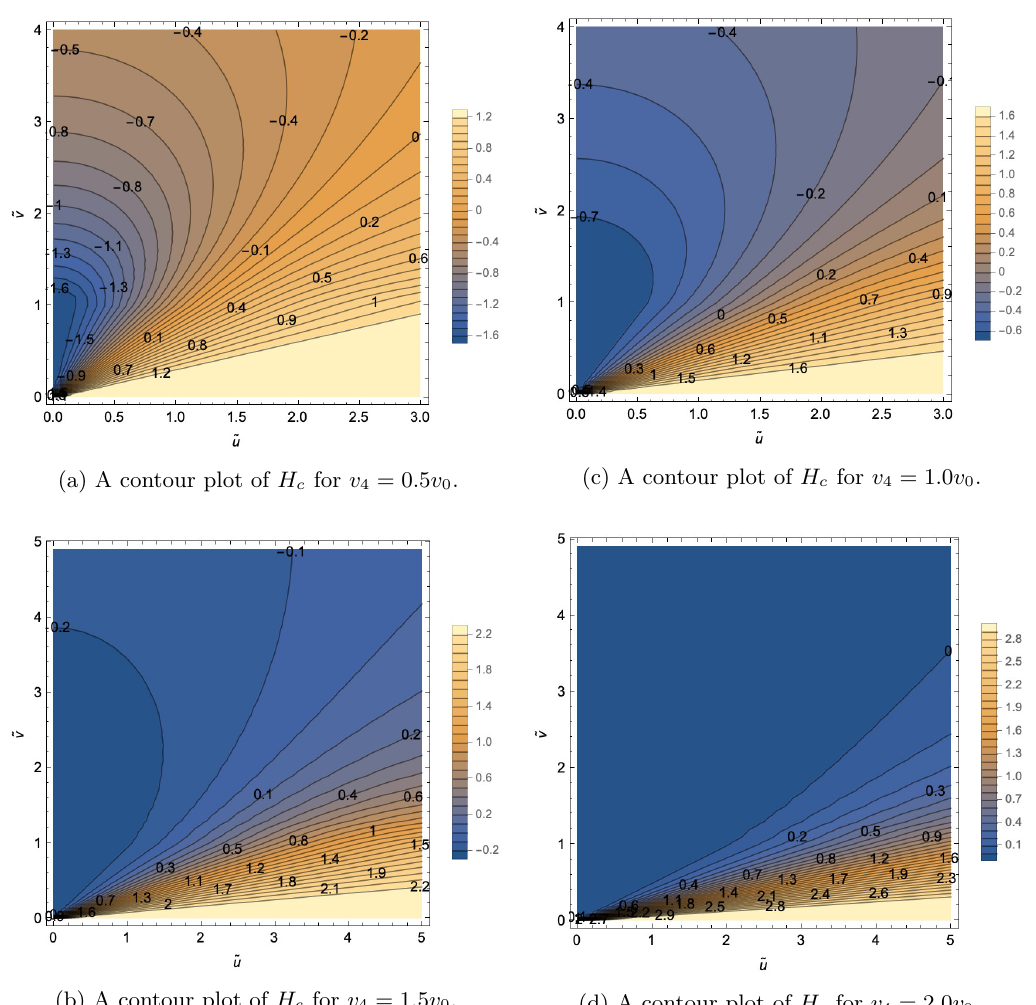
Figure 3 . Contour plots of the correction function H c from equation (4.27) for different values of the parameter v 4 /v 0